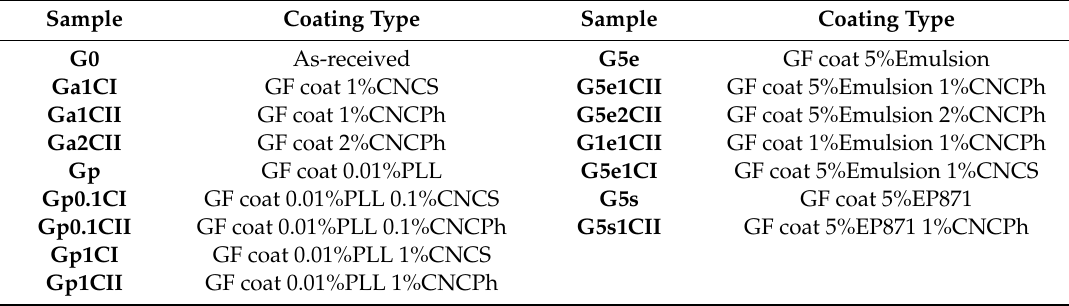
Table 2. Coating preparations and their respective labels.